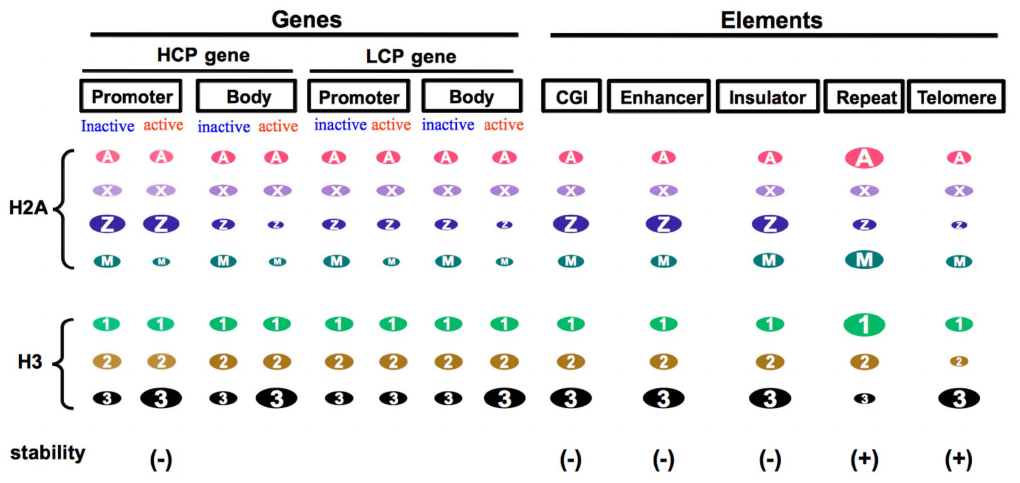
Figure 9. Schematic view of histone variant enrichment in various genome regions. Relative enrichment of each histone variant in various genome regions is indicated by the ellipse magnitude. Stability ( + ) and ( 2 ) indicate stable and unstable chromatin, respectively. Chromatin was unstable only in regions enriched for both H2A.Z and H3.3.